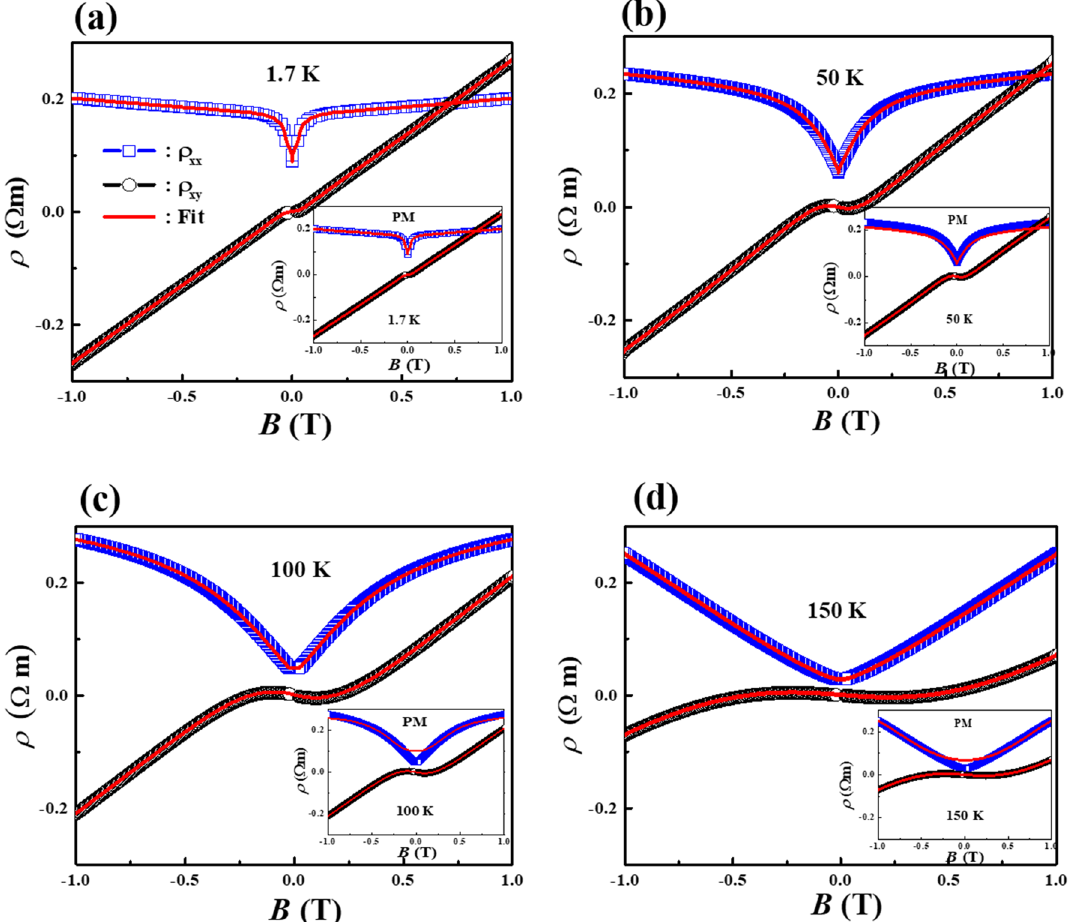
Figure 3. ( a – d ) Magnetic field dependence of transverse resistivity ρ xx ( B ) and Hall resistivity ρ xy ( B ) of the Bi 0.97 Sb 0.03 single crystal at T = 1.7 K, 50 K, 100 K, and 150 K, respectively. The solid lines represent theoretical curves obtained by fitting ρ xx ( B ) and ρ xx ( B ) simultaneously, based on the new modified two-band model. The insets of ( a – d ) show theoretical curves obtained by fitting ρ xx ( B ) and ρ xx ( B ) simultaneously, based on the previous